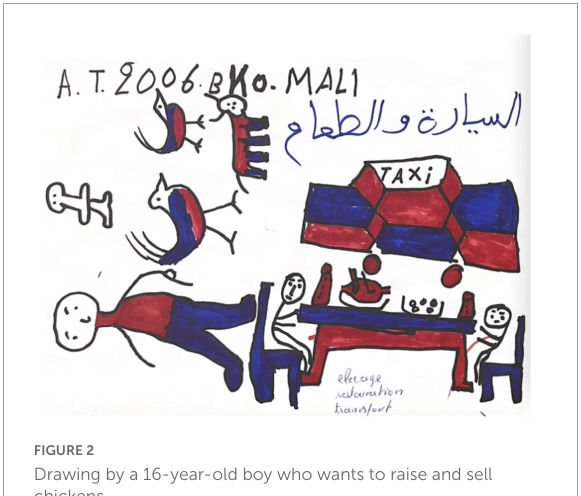
FIGURE1 Drawing aof a 13-year-old girl who wants to become a seamstress.